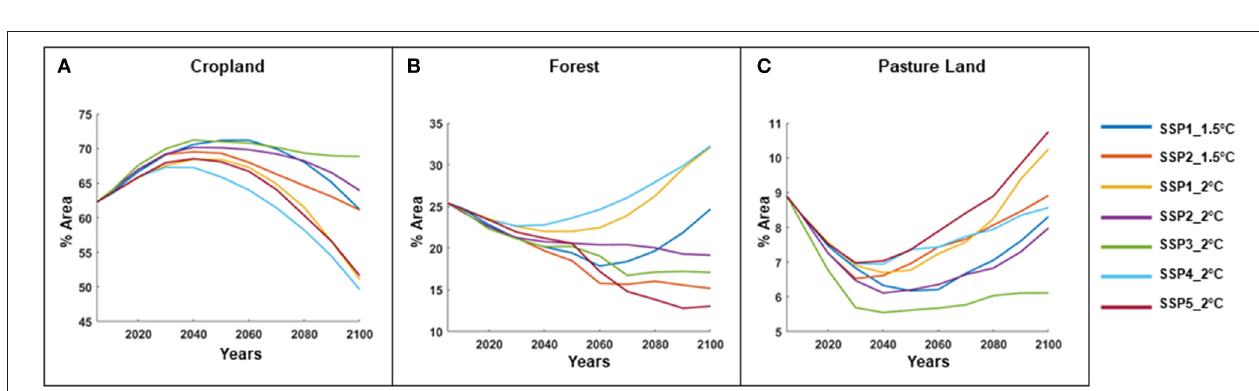
FIGURE 6 | Time evolution of percentage area of (A) cropland, (B) forest, and (C) pasture land at Ganga river basin, for each combination of RCP-SSP scenario over twenty-first century, as projected by AIM/PLUM model.